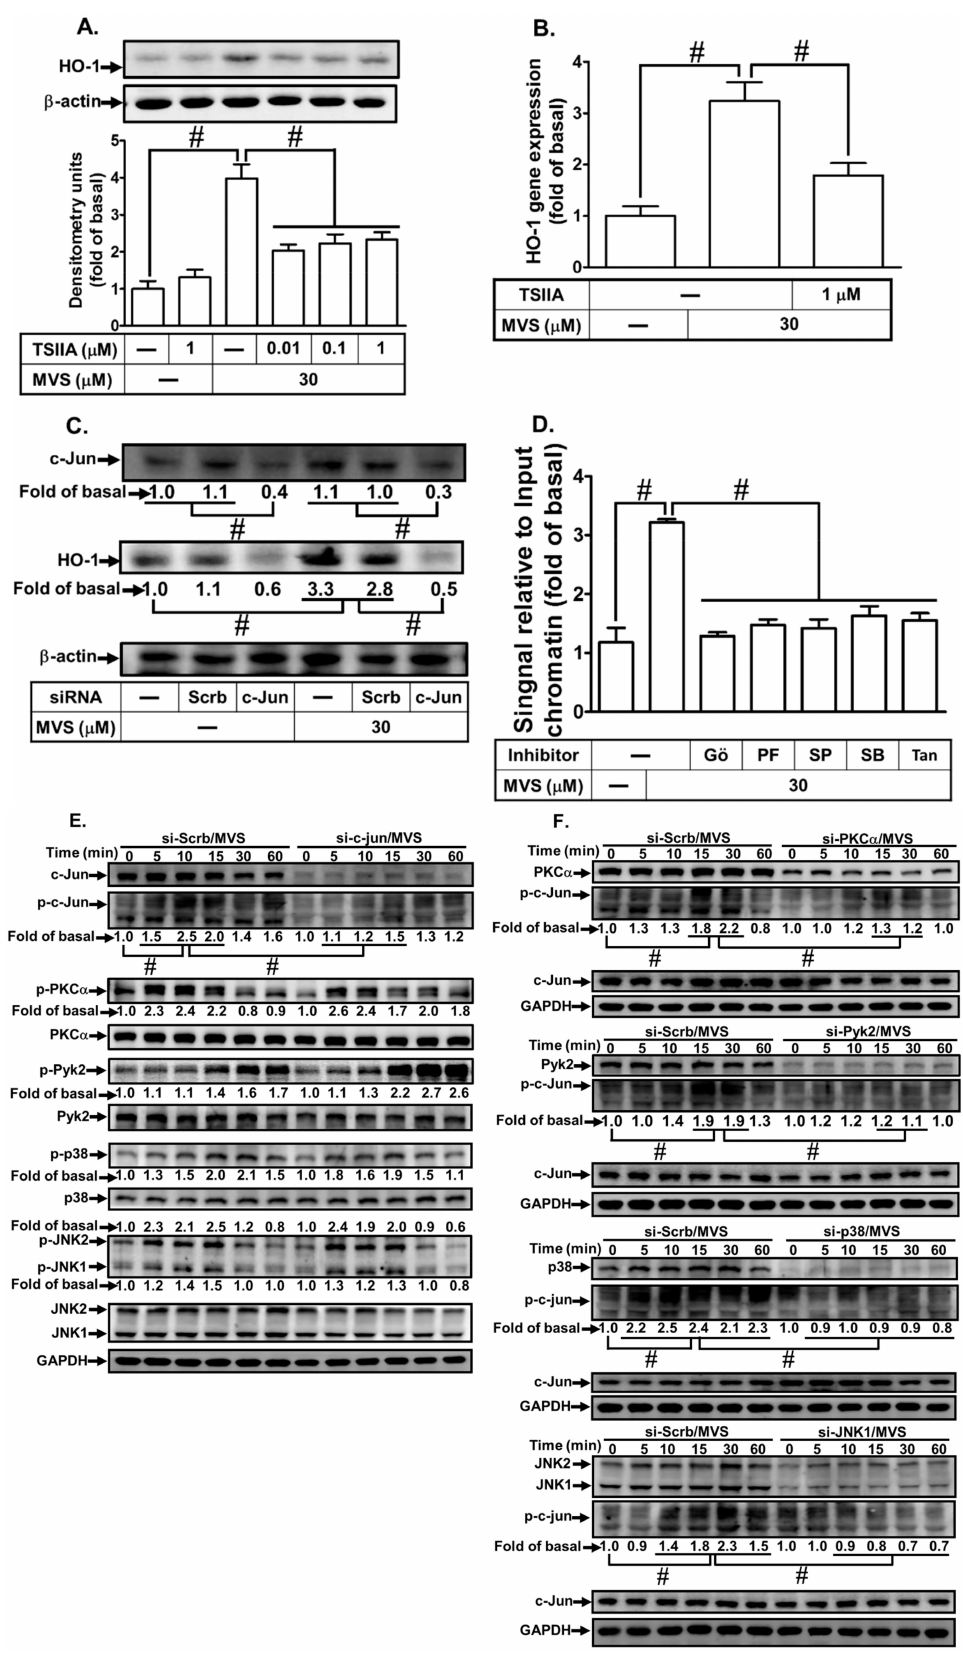
Figure 6. The involvement of PKC α / Pyk2 / p38 MAPK or JNK1 / 2-dependent c-Jun / AP-1 activation in the MVS-induced HO-1 expression. ( A ) The cells were pretreated with various concentrations